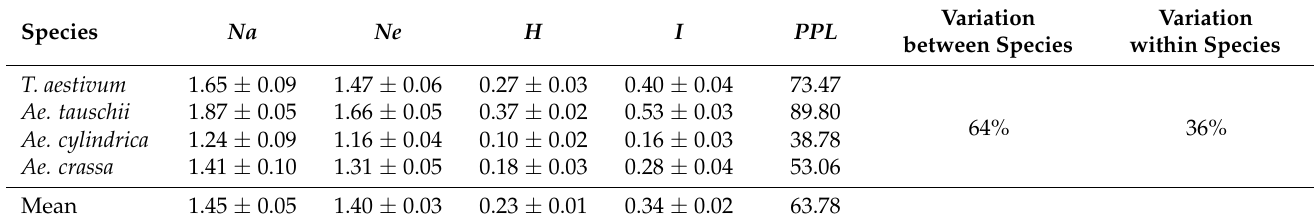
Table 2. Estimated genetic variation parameters using SSR markers in four investigated wheat germplasm.